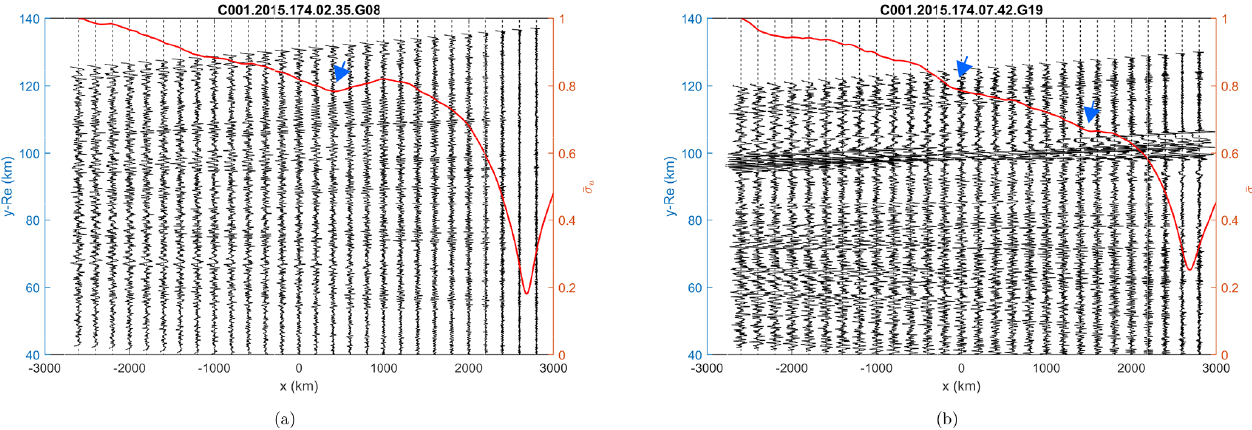
Figure 15. BP amplitudes of COSMIC occultation events during geomagnetic storms. The right y axis corresponds to the values of the normalized BP amplitude standard deviation (red curve). The global minimum in the red curves estimates a similar position of the main irregularity region for both occultations ( x = 2600–2800km). The arrows highlight local minima, which may indicate the existence of other